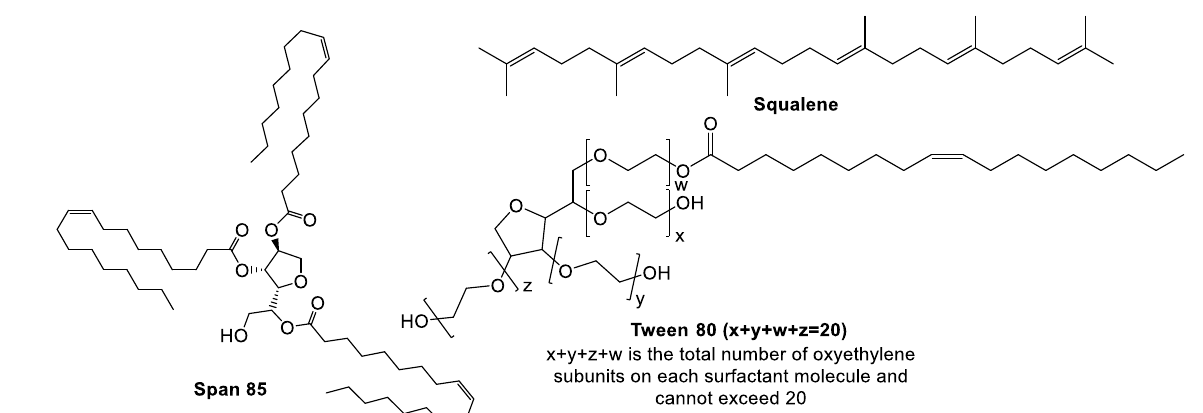
Figure 3. Chemical components of MF59 ® , where MF59 ® is composed of squalene and two surfactants (Span 85 and Tween 80). MF59 ® and AS03 not only have similar components, but also analogous composition. These are mixed in an oil phase giving oil-in-water emulsions.